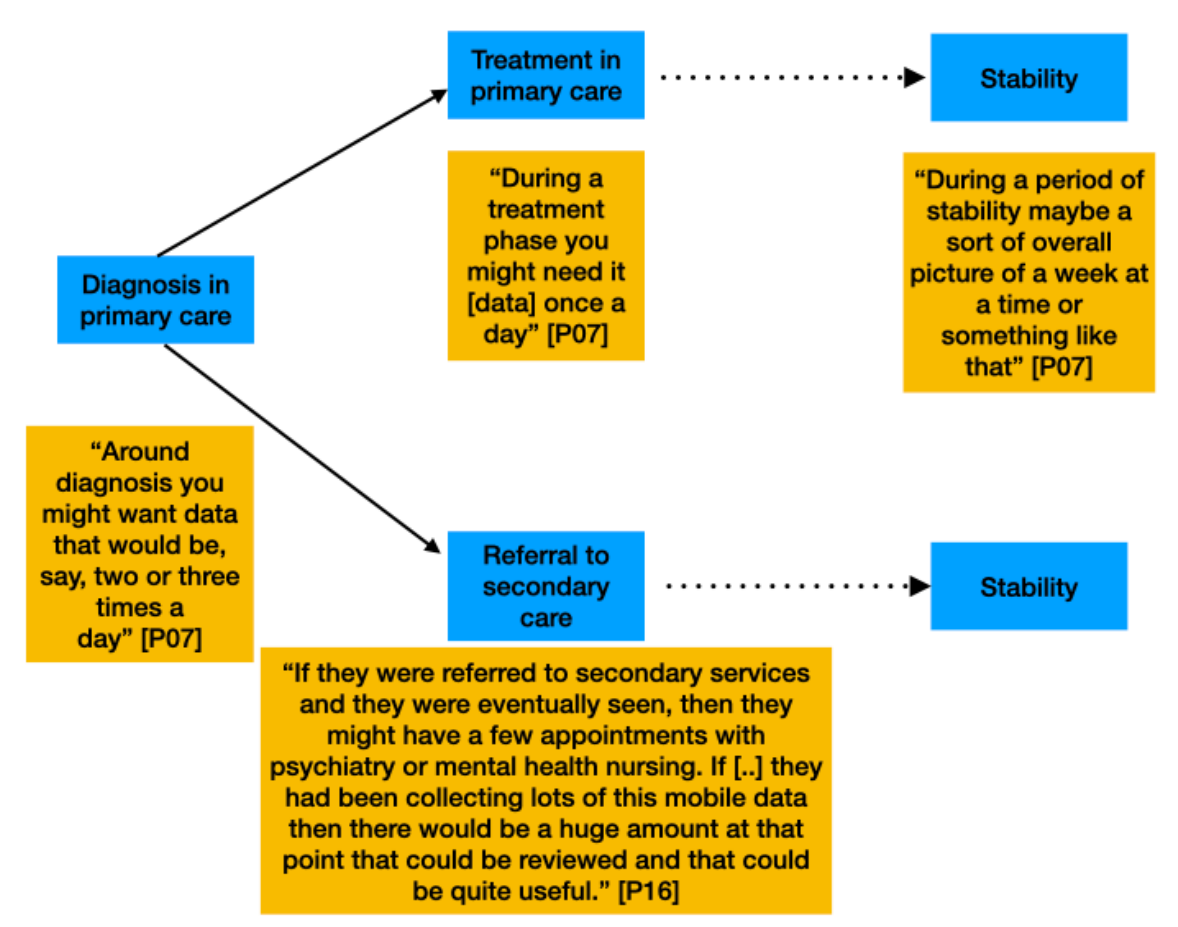
Figure 2. Participants’comments about the timing of the use of remote measurement technology in the depression care pathway, including monitoring during a change in treatment.